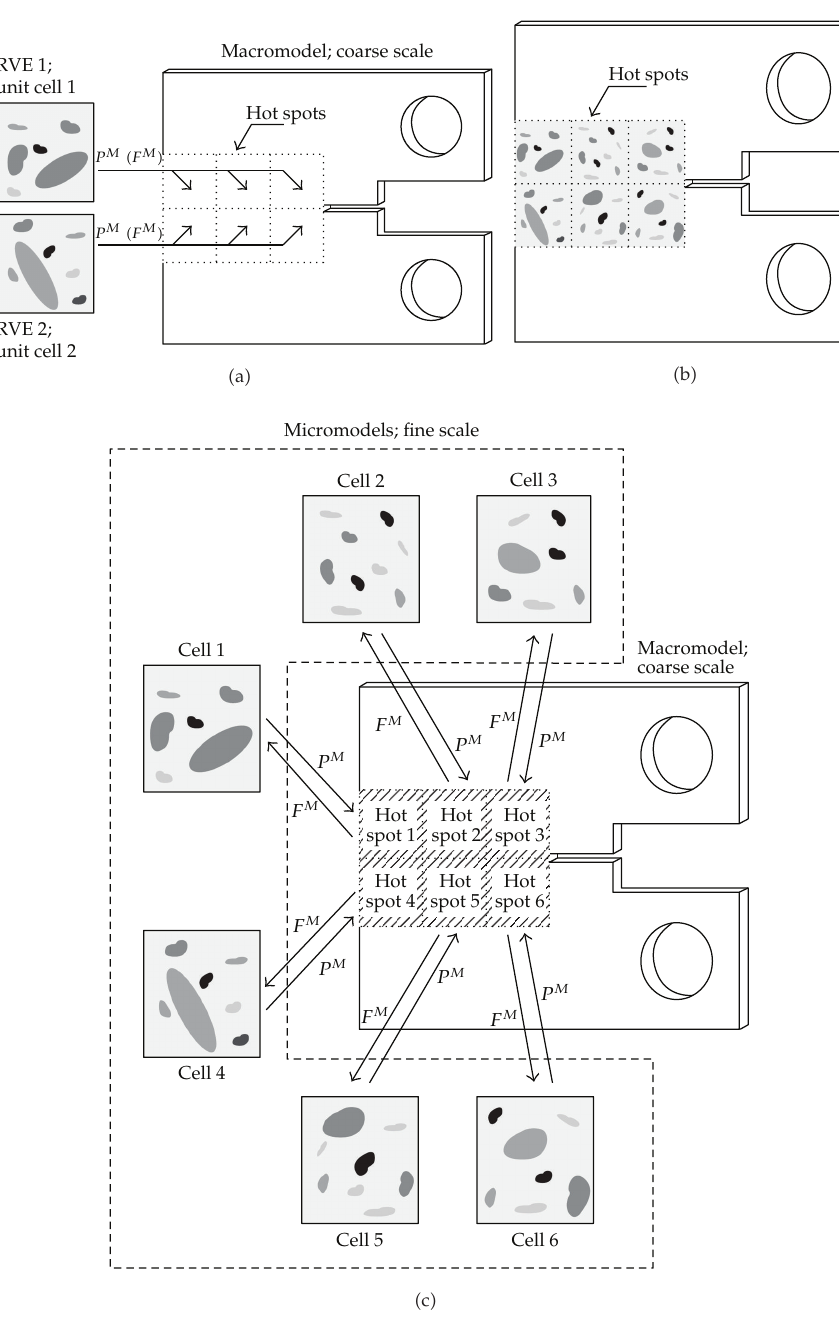
Figure 1: Schematic of a (cid:5) a (cid:6) hierarchical, (cid:5) b (cid:6) concurrent, and (cid:5) c (cid:6) semiconcurrent multiscale methods adopted from (cid:2) 12 (cid:3)